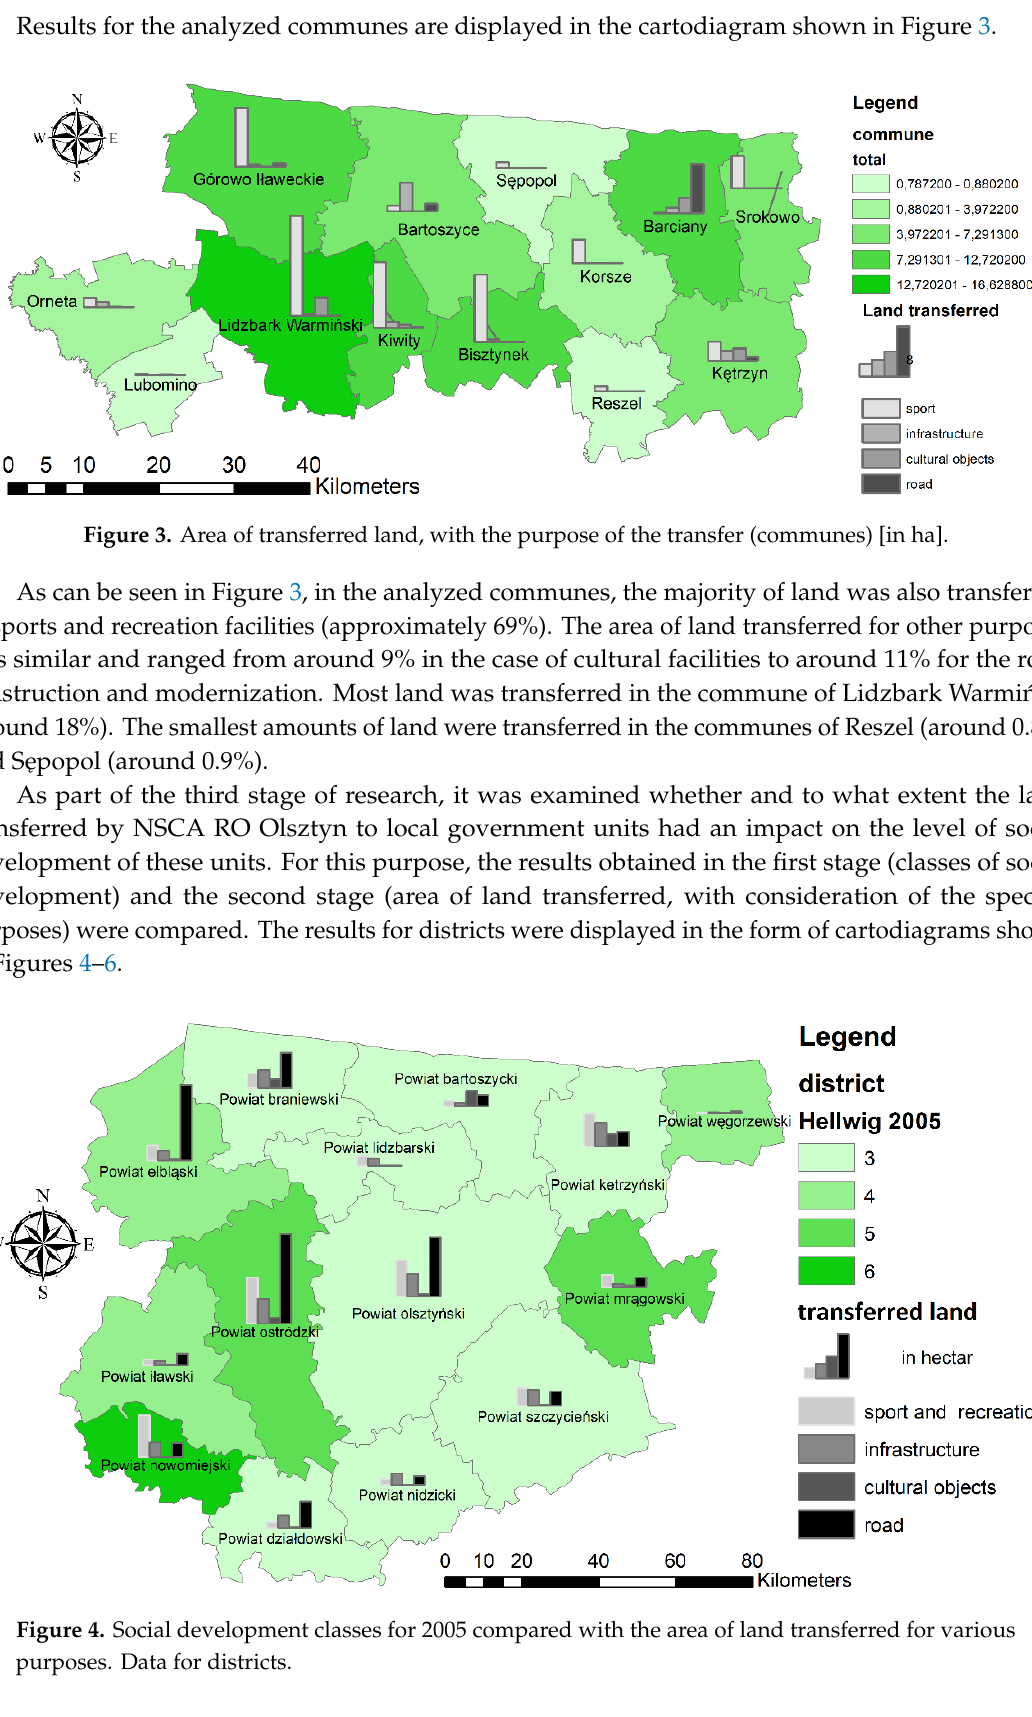
Figure 4. Social development classes for 2005 compared with the area of land transferred for various purposes. Data for districts.